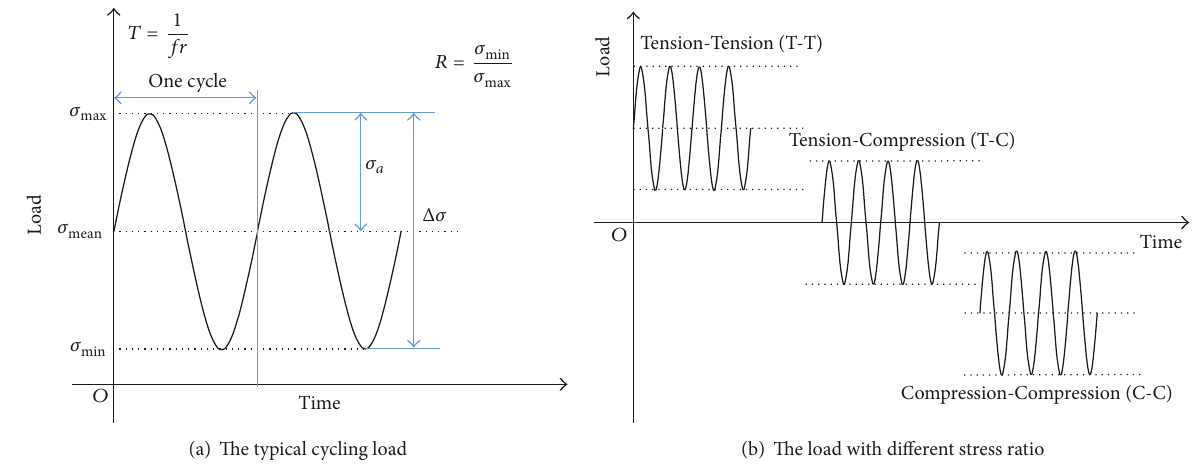
Figure 6: The constant amplitude load of fatigue test for composite materials.